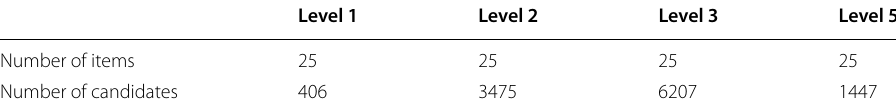
Table 1 The 100 items included in the study